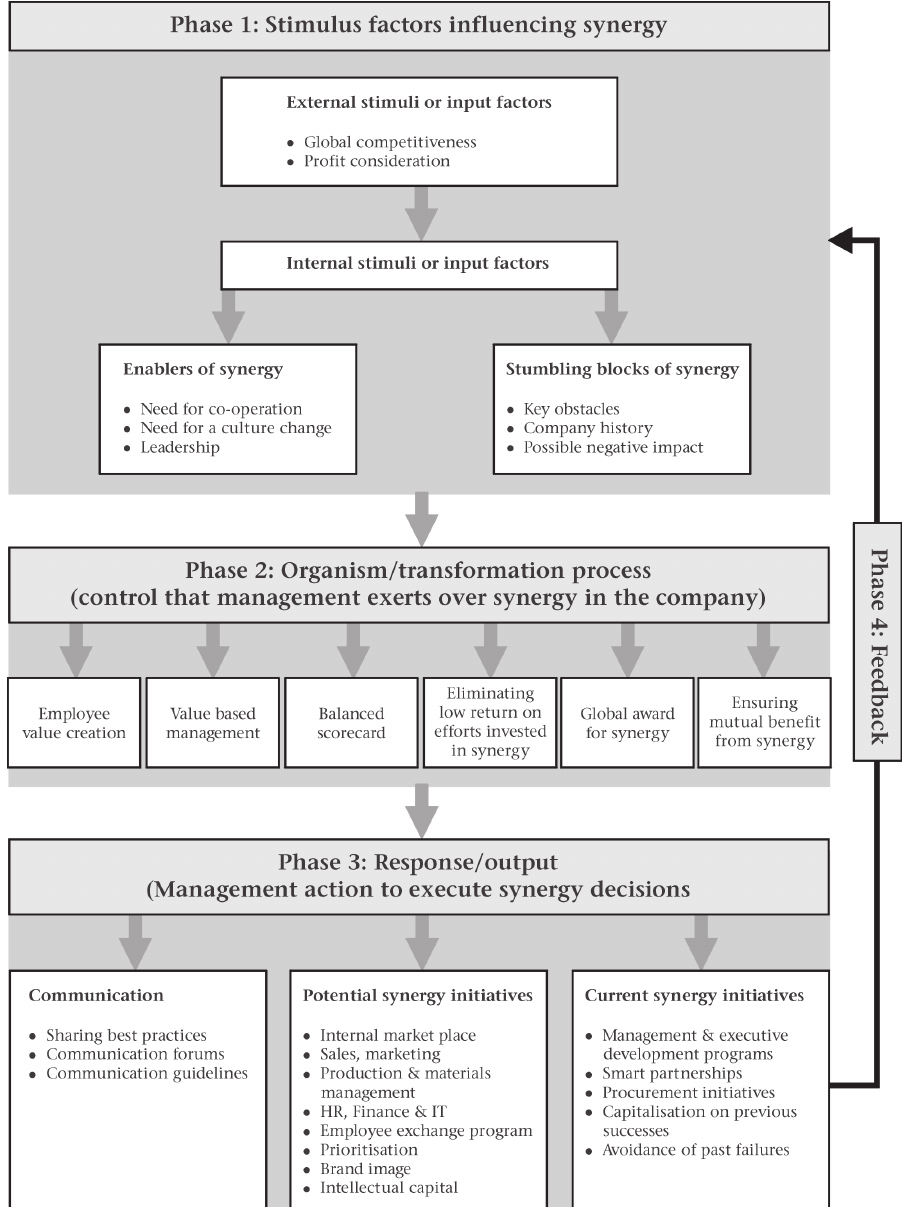
Figure 1: Substantive theory for leading a change process towards